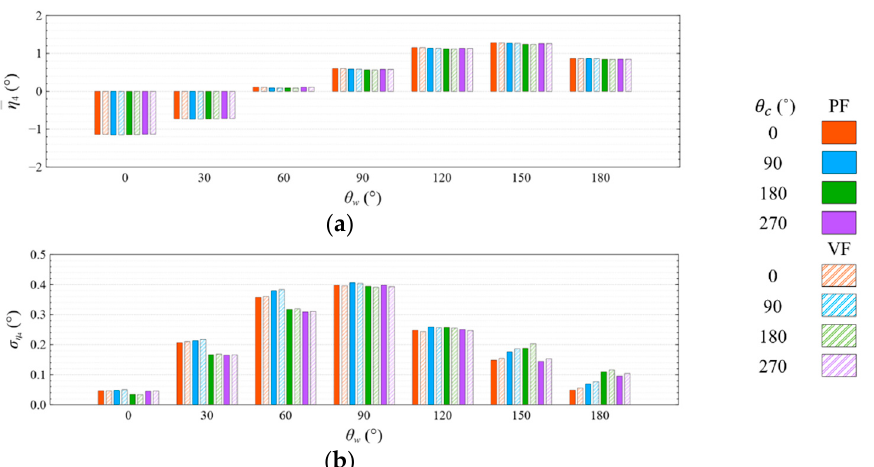
Figure 24. Comparison of ( a ) means and ( b ) standard deviations of platform roll motion under HW condition.